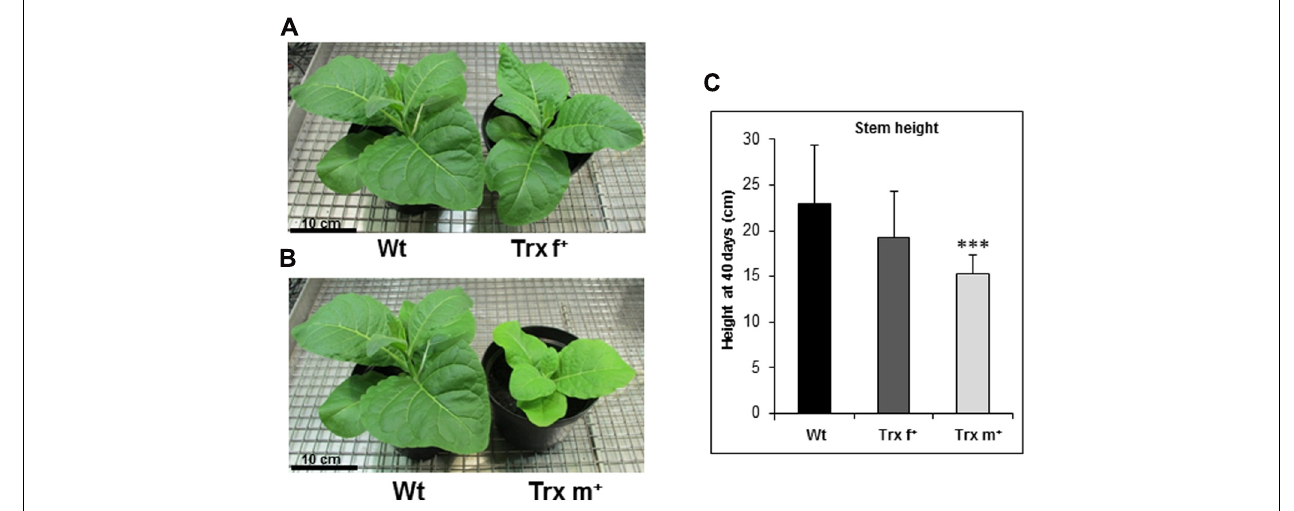
is shown in panels (A) and (B) . (C) Stem height of Wt and transplastomic plants grown for 40 days in standard conditions. Mean stem height values ± SD were gained from 15 plants per genotype. Wt, wild-type; Trx f + and Trx m + , plants overexpressing Trx f or Trx m, respectively. ***Significantly different from Wt with p < 0.001 ( t